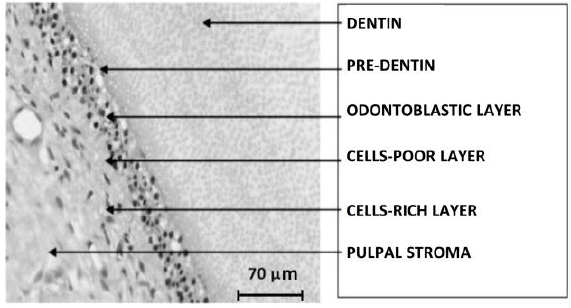
Figure 5. The structure of the dental pulp.